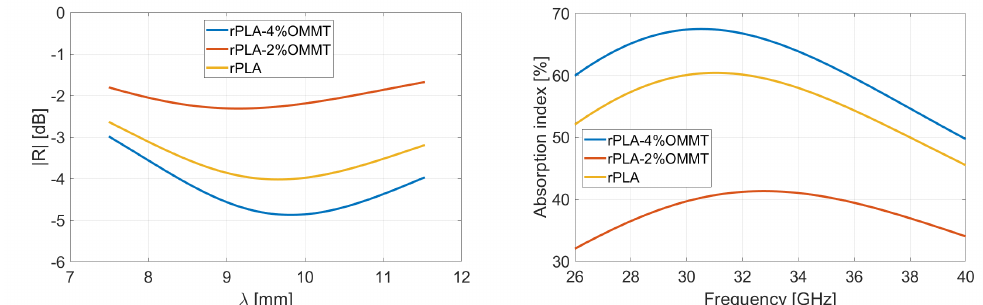
Figure 10. Simulation of reflectivity and absorption performances for recycled PLA–OMMT nanocom- posites in Rozanov configuration. The thickness of films is set at 1.4 mm.